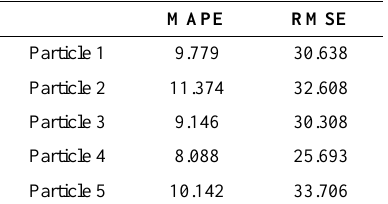
Table 23. MAPE and RMSE calculations in the initial iteration MAPE